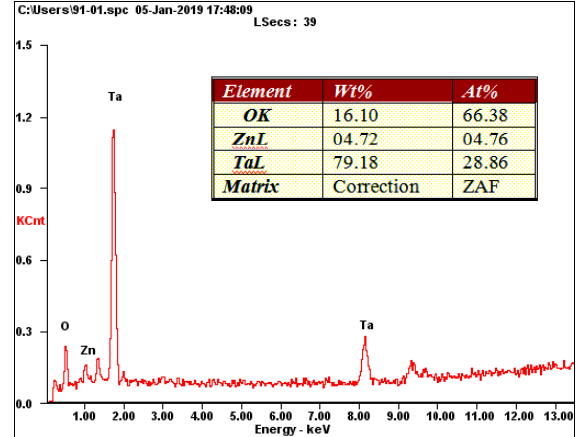
Figure 6. EDS element image of the ZnO-TaxOy coating.